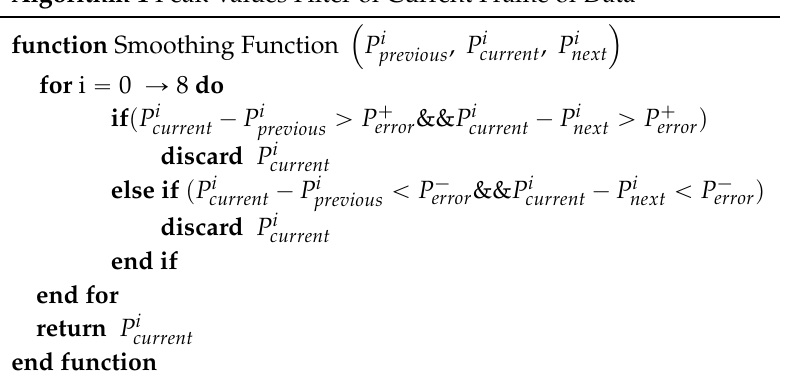
Algorithm 1 Peak Values Filter of Current Frame of Data function Smoothing